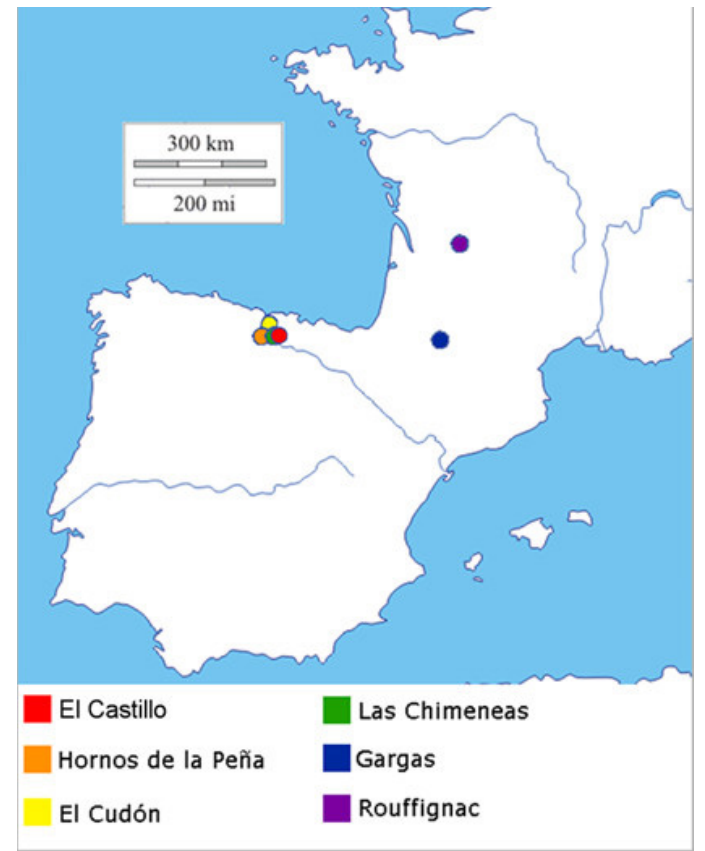
Figure 1. Distribution of caves in the Franco-Cantabrian region discussed in this